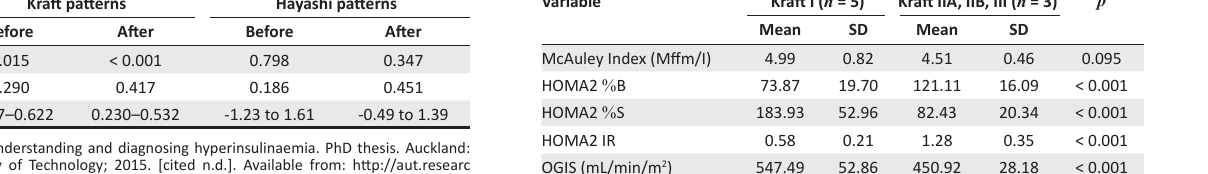
TABLE 7: Insulin resistance measures compared to insulin response patterns. Variable